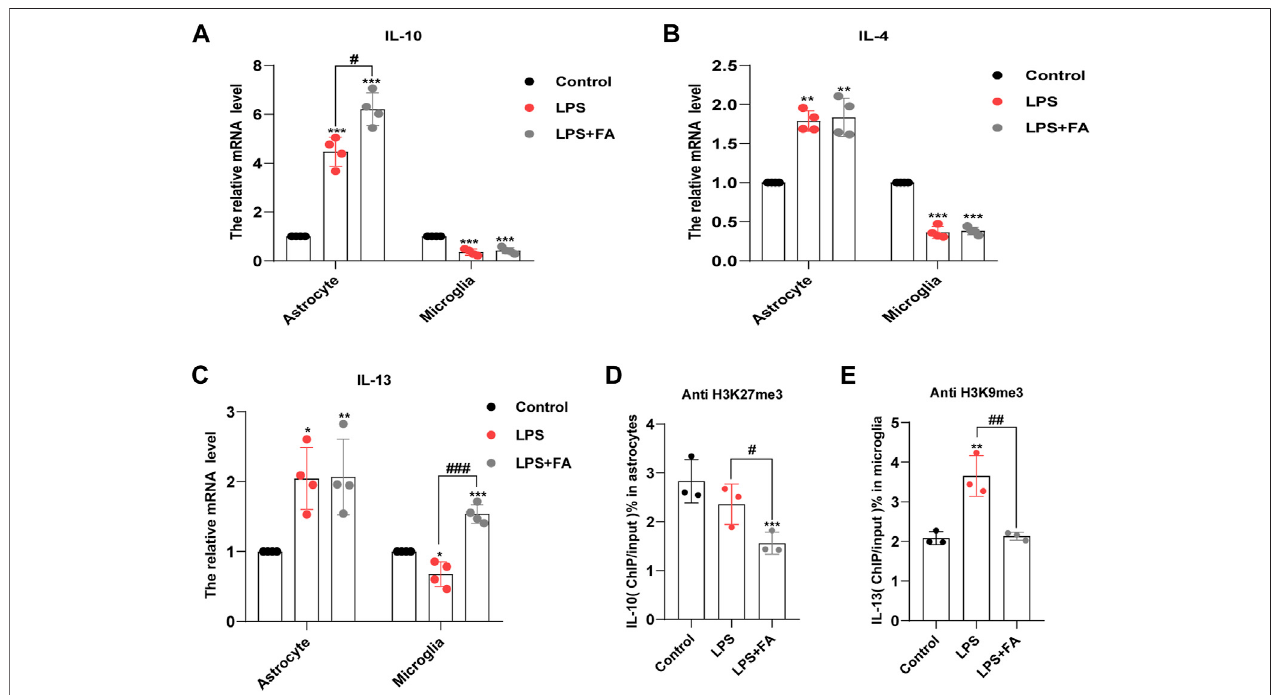
FIGURE 7 | FA increased the binding of H3K27me3 with IL-10 promoter, and H3K9me3 with IL-13 promoter in astrocytes and microglia, respectively. (A) Quanti fi cation of the mRNA levels of IL-10 in primary astrocytes and microglia. FA had an effect on the expression levels of IL-10 only in astrocytes. (B) Quanti fi cation of the mRNA levels of IL-4 in primary astrocytes and microglia. (C) Quanti fi cation of the mRNA levels of IL-13. FA had an effect on the expression levels of IL-13 only in microglia. (D) Primaryastrocyteswereimmunoprecipitatedwithanti-H3K27me3antibody,andtheisolatedDNAwasanalyzedbyusingIL-10ChIP-qPCRprimers. Compared with the LPS group, the level of H3K27me3 in the IL-10 promoter region decreased signi fi cantly in FA-treated astrocytes. (E) Microglia cells were immunoprecipitated with anti-H3K9me3 antibody, and the isolated DNA was analyzed by using IL-13 ChIP-qPCR primers. Compared with the LPS group, the level of H3K9me3 in the IL-13 promoter regions decreased signi fi cantly in FA-treated microglia. Rabbit IgG was used asa negative control. DNA from each ChIP-qPCR sample wasnormalizedbythe corresponding inputsample. Data:mean ±SEM; * p < 0.05, ** p < 0.01, *** p < 0.001versusthecontrol group; # p < 0.05, ## p < 0.01, ### p < 0.001 versus the PIA group; n = 3 – 4 per group (one-way